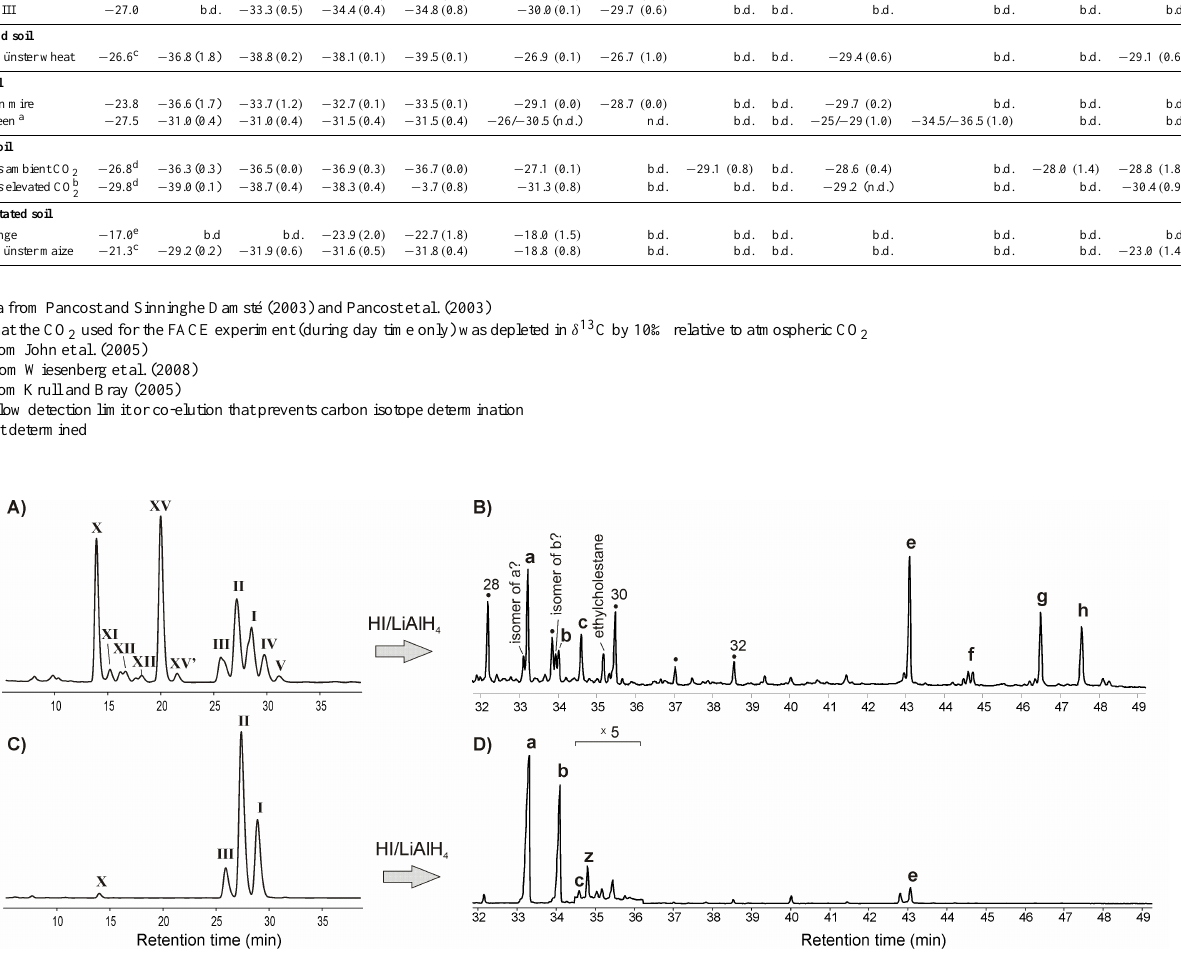
Fig. 2. Partial LC and GC chromatograms of the FACE soil under ambient CO 2 conditions ( A and B , respectively) and of the Stordalen mire peat ( C and D , respectively). The polar fraction of the total extracts, containing the GDGT compounds (roman numerals in A and C, numbers refer to Fig. 1), has been enriched in GDGTs by means of preparative HPLC. Subsequently, the alkyl moieties have been released by cleaving the ether bonds with an HI/LiAlH 4 treatment. The GC chromatograms shown in B and D represent the hydrocarbon fraction obtained from the respective samples after this treatment. Letters a–h refer to the structures in Fig. 1. Bullets represent n -alkane series with corresponding chain length that most likely derive from dehydration of higher plant derived n -alkanols and subsequent reduction of the double bond by LiAlH 4 . The peaks eluting just before peak a and b have the exact same mass spectrum and are therefore suggested to be stereoisomers of a and b, respectively. The peak indicated wit z in panel D is tentatively identified as 5,13,16,24-tetramethyloctacosane, see Fig. 3. Note that the vertical scale in panel D is magnified 5 times between 34.5 and